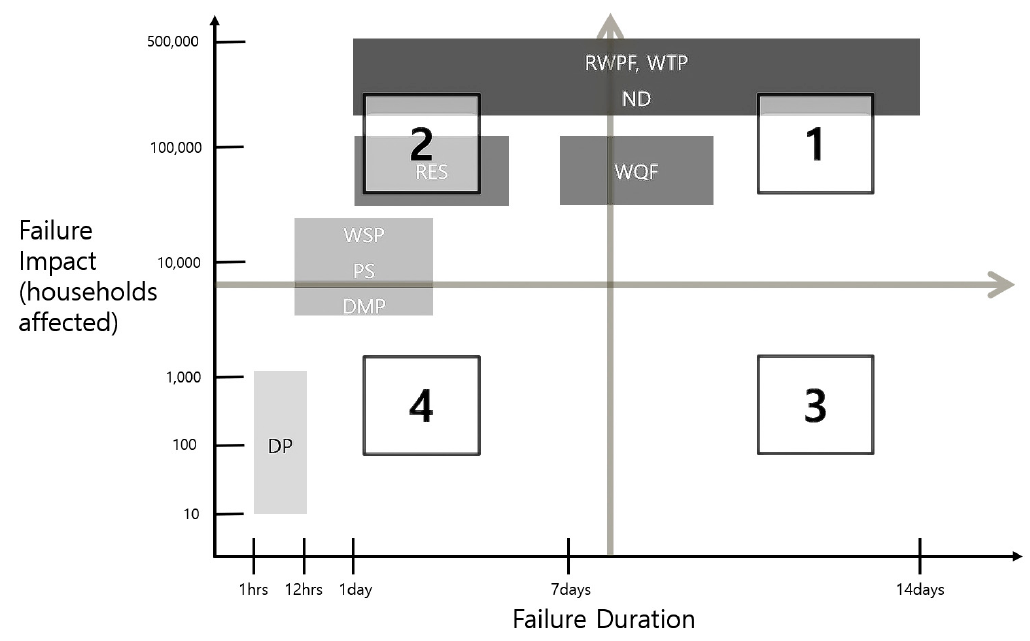
Figure 1. Example of the proposed failure cause–impact–duration (CID) plot.